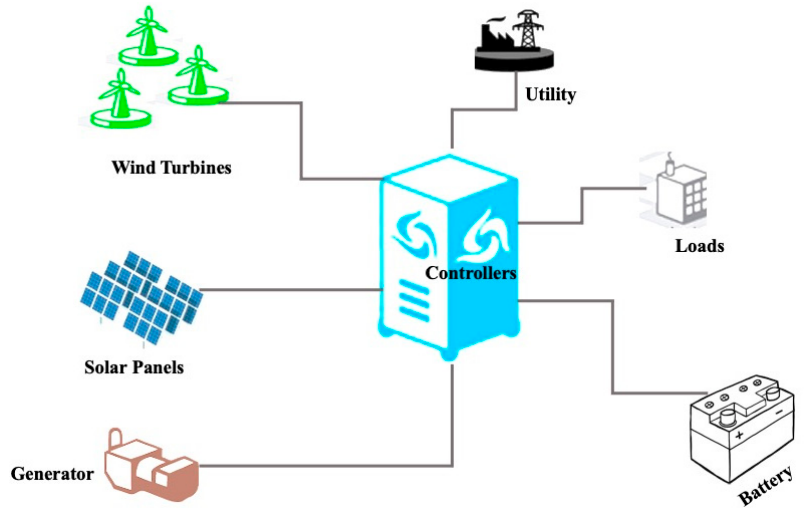
Figure 3. Schematic of a microgrid connected with Utility grid.